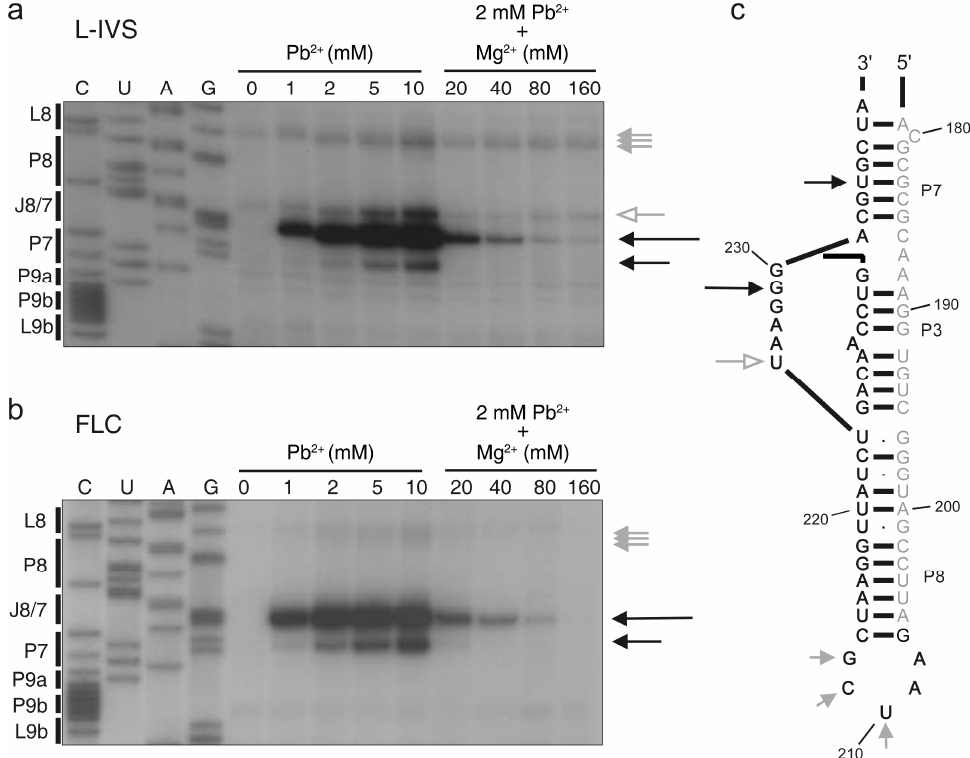
Figure 4. Pb 2+ induced cleavages in the catalytic core. ( a ) Primer extension analysis of DiGIR2 L-IVS probed with increasing concentrations of Pb 2+ compared to a control (lane 0–5) and cleavage at a constant Pb 2+ concentration (2 mM) in presence of increasing concentrations of Mg 2+ (lane 6–9). To the right, grey arrows indicate Mg 2+ independent Pb 2+ cleavage sites; black arrows indicate cleavages affected by Mg 2+ concentration. The length of the arrows as in Figure 3 represents signal strength (1 to 3). To the left is a DiGIR2 sequencing ladder electrophoresed in parallel with samples and bars indicating structural elements in DiGIR2; ( b ) Primer extension analysis of Pb 2+ cleavage of DiGIR2 FLC. Figure annotations are identical to (a); ( c ) Results from (a) and (b) depicted on a secondary structure diagram of the J8/7 region. Gray letters indicate nucleotide positions that are not covered in (a) and (b). The open grey arrow indicates the L-IVS specific Pb 2+ cleavage at U225.